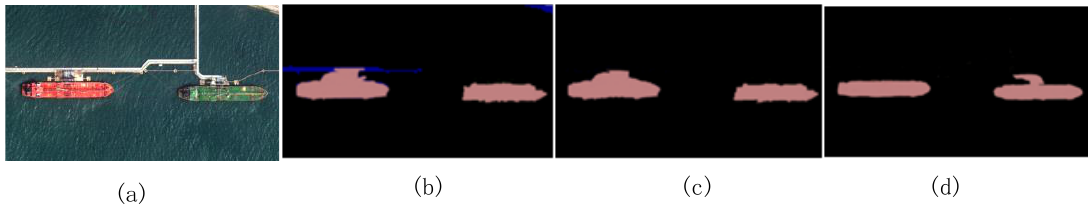
Figure 6. Semantic segmentation of ships under sea clutter. ( a ) Original ( b )CRF-RNN ( c ) DeepLab ( d ) Proposed model